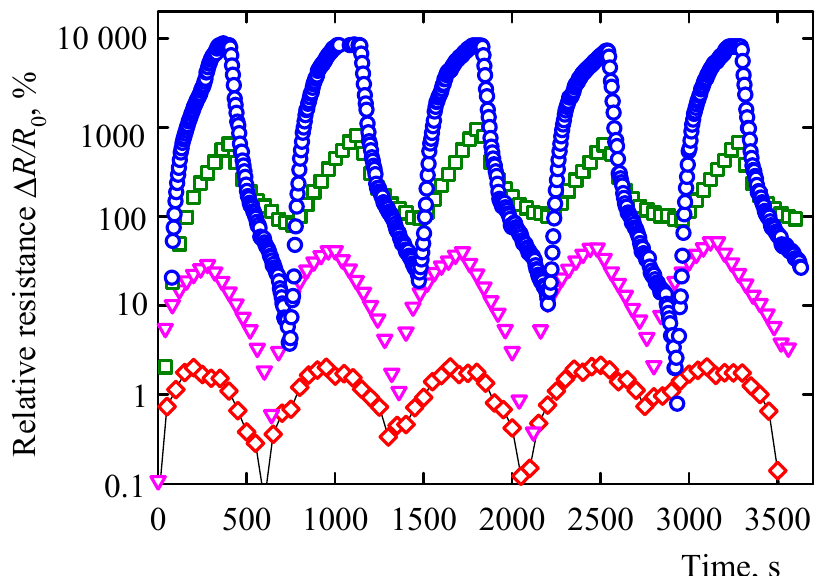
Figure 6. The time-dependent relative resistance of the MWCNT/EOC composite sensor in the presence of saturated vapors of heptane (blue circles), toluene (dark green squares), acetone (pink triangles), and ethanol (red diamonds) in the course of five consecutive adsorption/desorption cycles. The mechanism underlying the increase in resistance of the MWCNT/polymer com- posite in the presence of VOCs has been explained as a consequence of an adsorption of the VOCs on the MWCNT surface and of a marked expansion of the volume of the composites [1–4,12,13]. A swelling of the underlying matrix results in the formation of non-conducting layers between the embedded nanotubes, which separates the nanotubes and thus, decreases the number of conductive inter-tube contacts [17,18]. The extent of the swelling depends on the correspondence between the Hildebrand solubility parameter of the polymer and the permeating solvent [40]. For example, when the Hildebrand solubility parameters δ = 15.5 MPa 1/2 for a polymer polydimethylsiloxane (PDMS) and a solvent are similar, the maximal expansion of the polymer ensues [40]. However, when the polarity and solubility of the solvent are greater than those of PDMS, the swelling of the polymer is progressively reduced [40]. By analogy, exposure of the MWCNT/EOC composite with δ of EOC of 16.4 MPa 1/2 [41] to heptane with a similar δ of 15.3 MPa 1/2 increased the relative resistance of the composite by almost 10,000% (Figure 7). However, penetrating vapors with higher δ such as toluene ( δ = 18.3 MPa 1/2 ) and acetone ( δ = 19.9 MPa 1/2 ) increased the relative resistance of the MWCNT/EOC composite to a lower extent by about 800% and 20%, respectively (Figure 7). Ethanol with δ = 26.2 MPa 1/2 did not substantially alter the relative resistance of the MWCNT/EOC composite (Figure